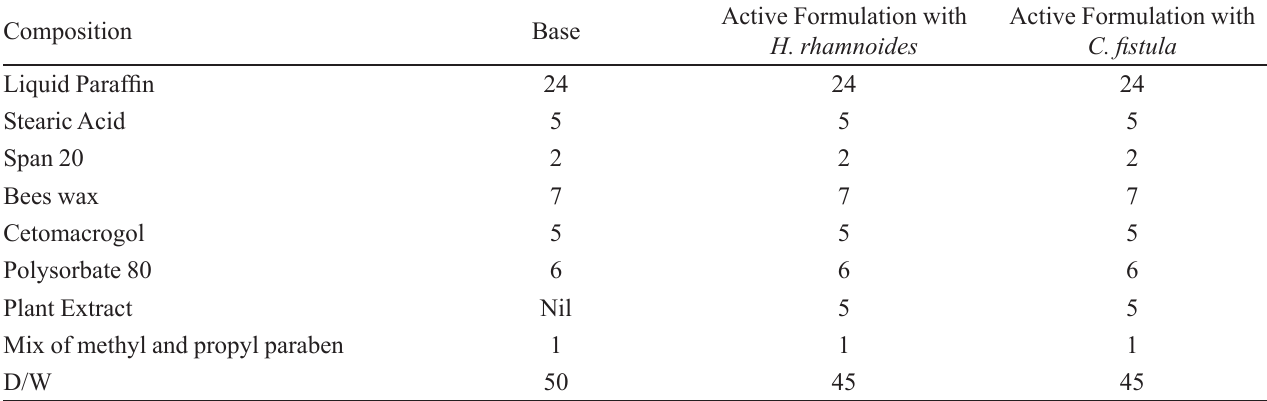
TABLE I - Composition of emulsions (%